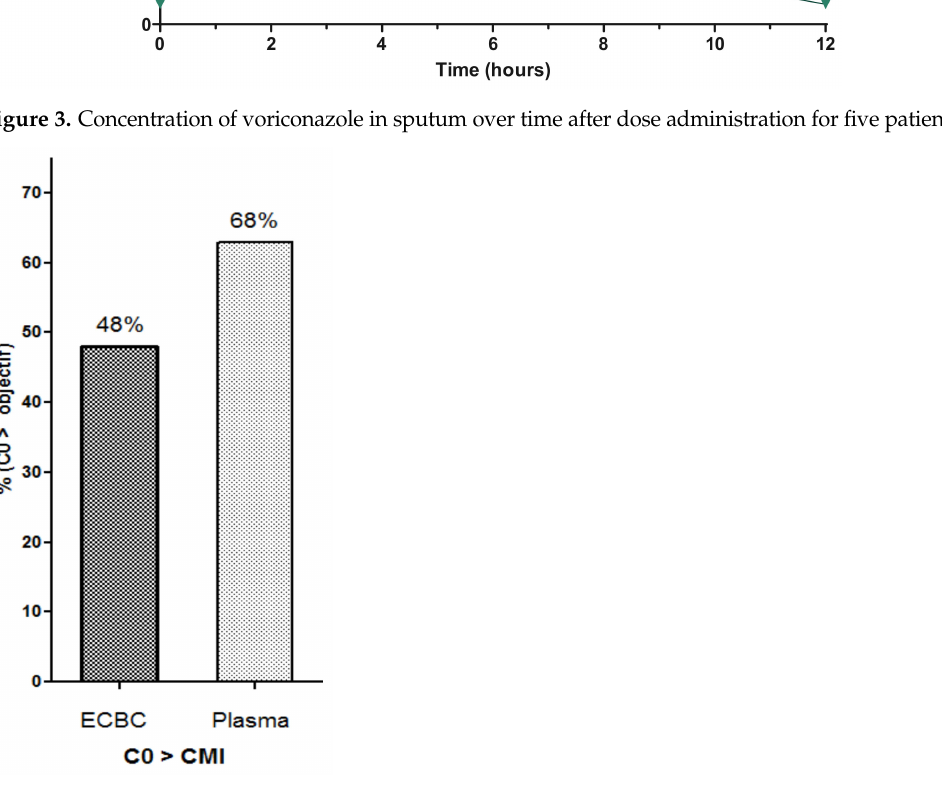
Figure 4. Percentage of samples with Cmin > MIC in sputum and plasma. MIC = minimum inhibitory